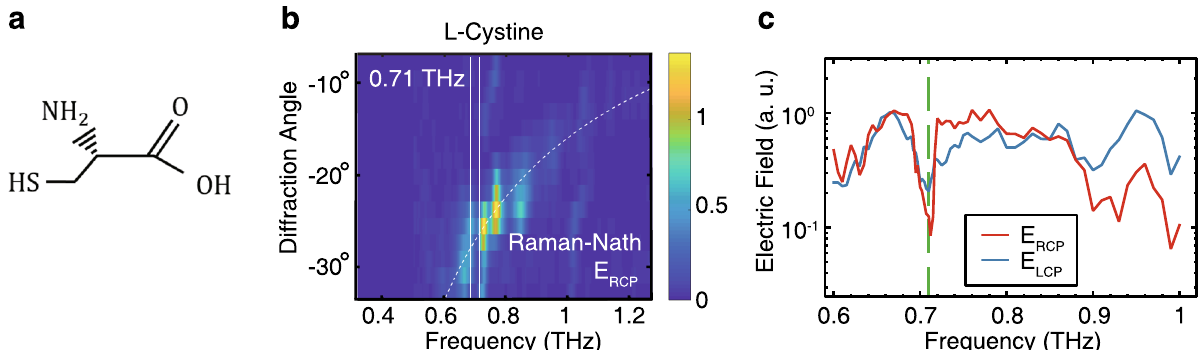
Fig. 5 THz circular dichroism spectroscopy of L -cystine. a L -Cystine molecular structure. This con fi guration is de fi ned as L as the amine group is to the left of the carbon chain. b Frequency distribution of the RCP electric fi eld after transmission through the L -cystine powder sample, with the absorption line visible at 0.71 THz. The frequency components are separated in space owing to the Raman-Nath diffraction. The dashed line shows the calculated